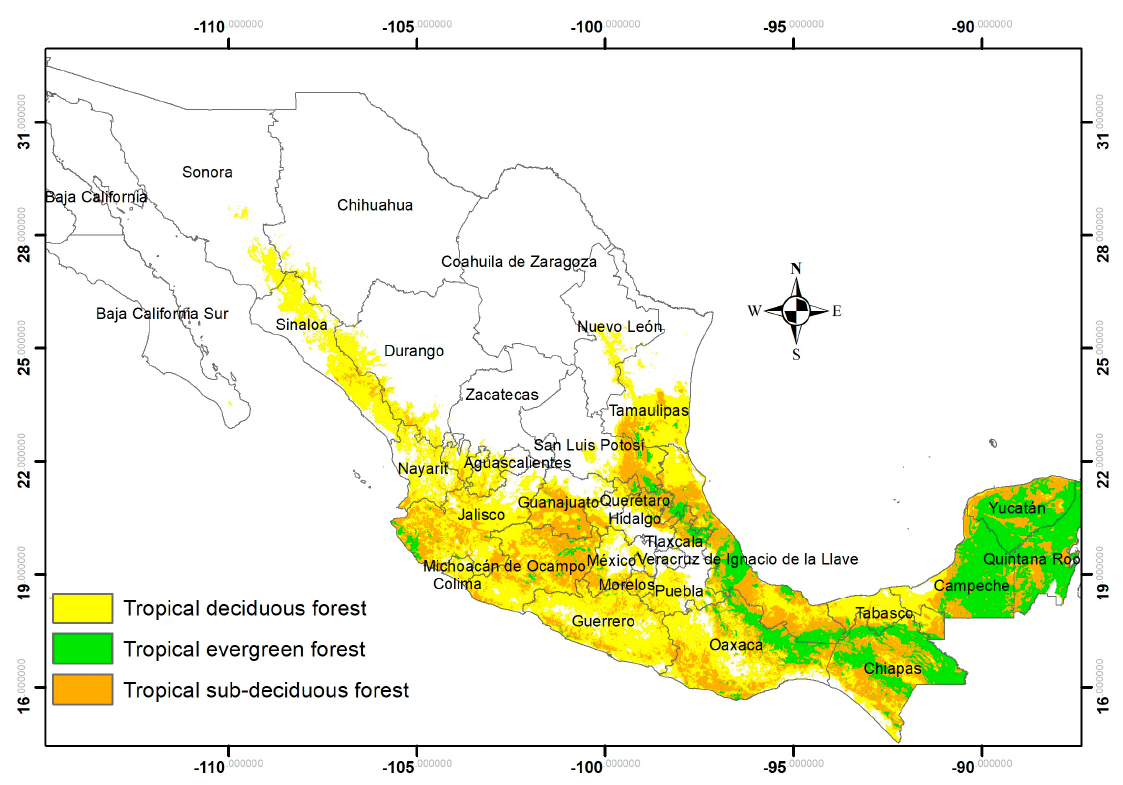
Figure 5. Distribution of the tropical forest in Mexico, as area of study for the distribution of C. odorata.